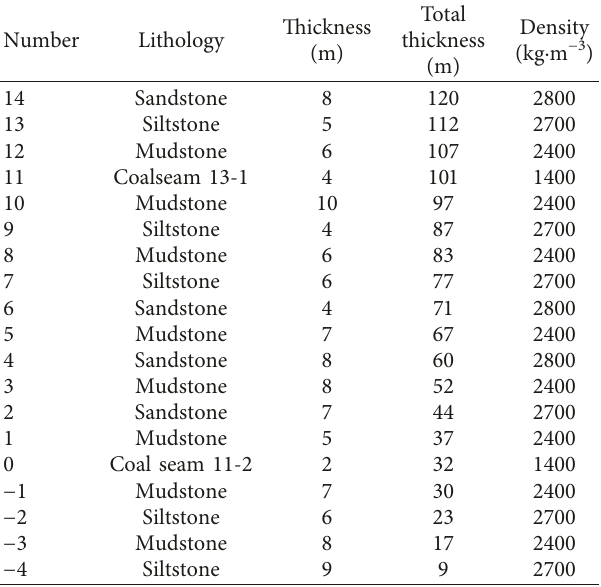
Figure 7: Dimension of numerical simulation model. Table 1: Distribution of strata and their parameters in the basic